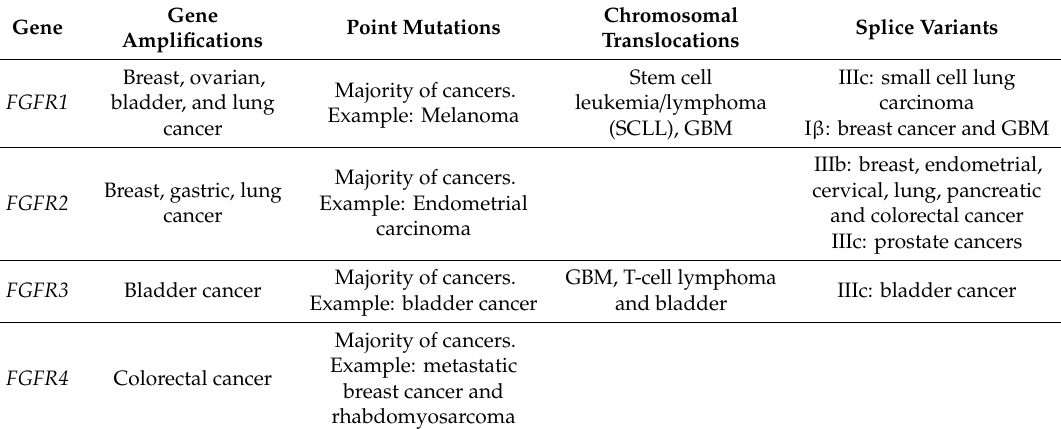
Table 1. Common FGFR genomic aberration in solid tumors. FGF signaling deregulation is involved in the development of many di ff erent human cancers. Four FGFR genomic alterations are represented in this table: gene amplification, point mutations, chromosomal translocations, and FGFR splicing isoforms. Each FGFR alteration is linked with the most significant cancers that contain those alterations. The role of the majority of the discovered point mutations in FGFR is unknown in cancer. Adapted from